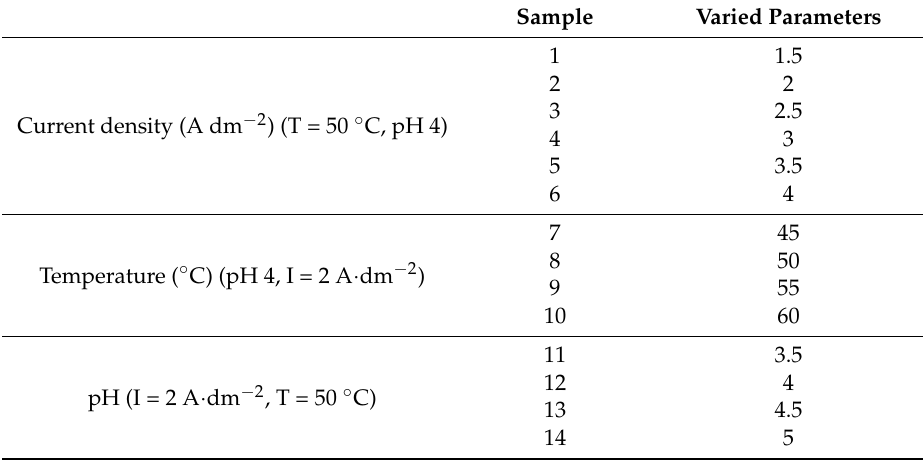
Table 1. Process conditions for the three groups of electrodeposition tests.